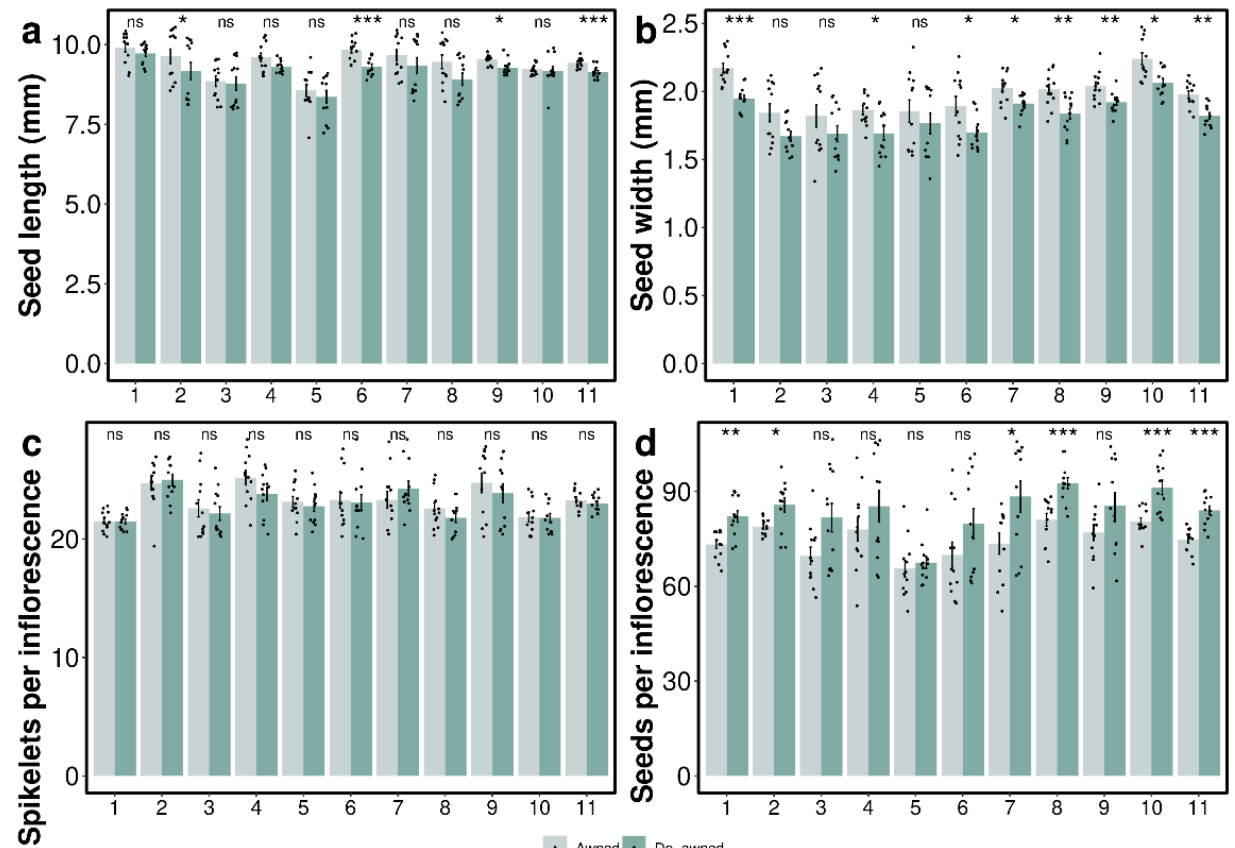
Figure 6. Seed length ( a ), seed width ( b ), spikelets per inflorescence ( c ), and seeds per inflorescence ( d ) of 10 Siberian wildrye accessions (1–10) and averages of accessions (11) under control and awn excision treatments across rainfed and irrigated conditions. Error bars represent mean ± standard deviation. ns: not significant, * p < 0.05, ** p < 0.01, *** p < 0.001.